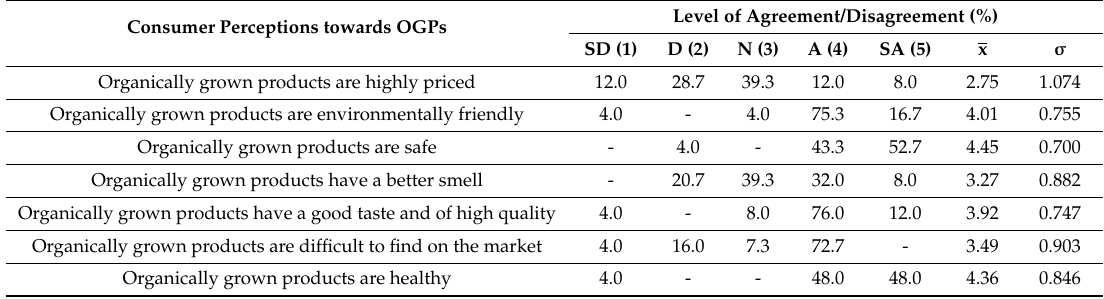
Level of Agreement/Disagreement